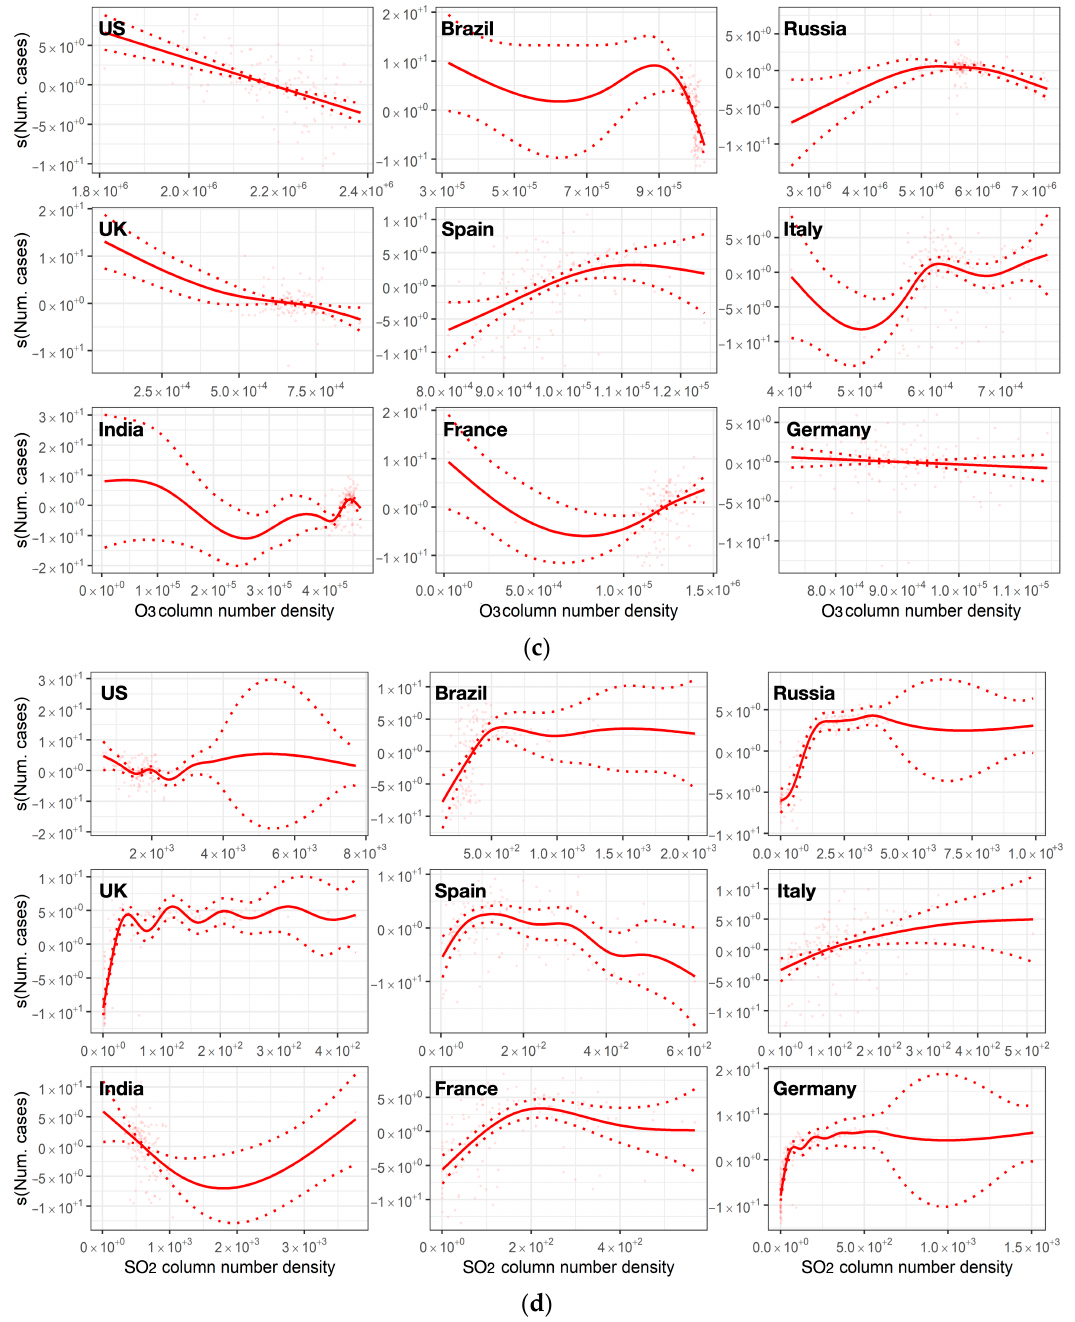
Figure 5. Margin effects (with confidence intervals) of air pollutions on confirmed cases in different countries. ( a ) CO column concentration; ( b ) NO 2 column concentration; ( c ) O 3 column concentration; ( d ) SO 2 column